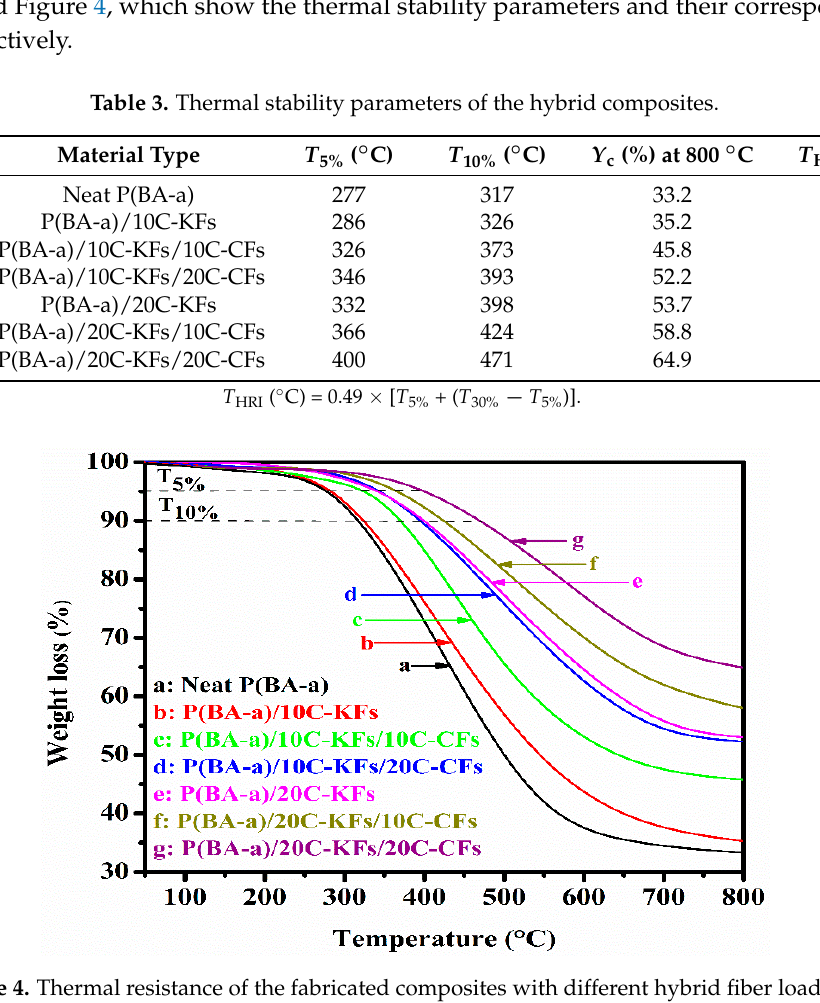
Figure 4. Thermal resistance of the fabricated composites with different hybrid fiber loadings.